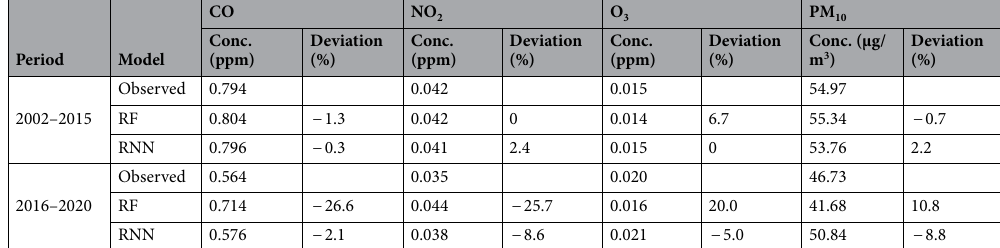
Table 1. Difference between the predicted value of the model and the actual observed value according to air pollutants. RF random forest, RNN recurrent neural network.